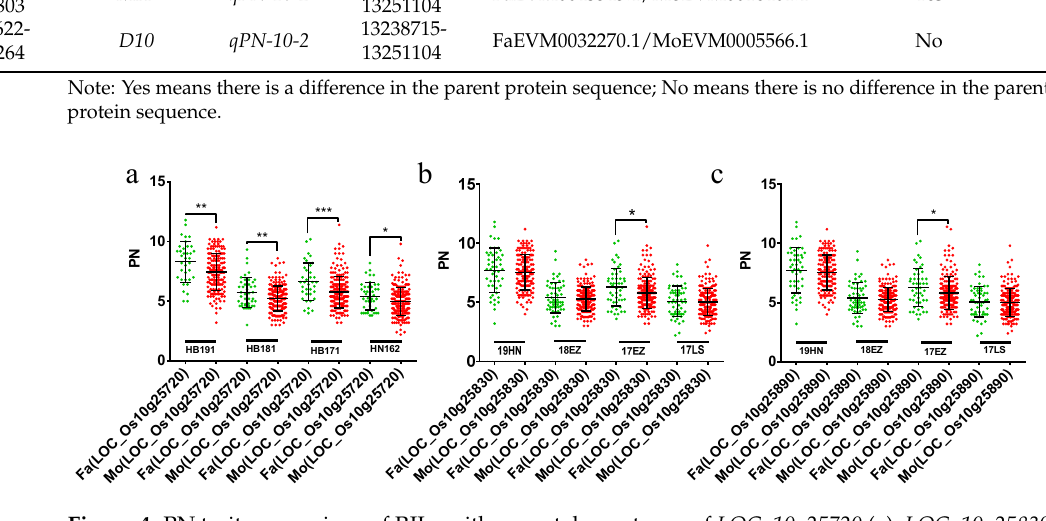
Table 1. Alignment results of parental protein sequences of three genes in qPN-10-2 .